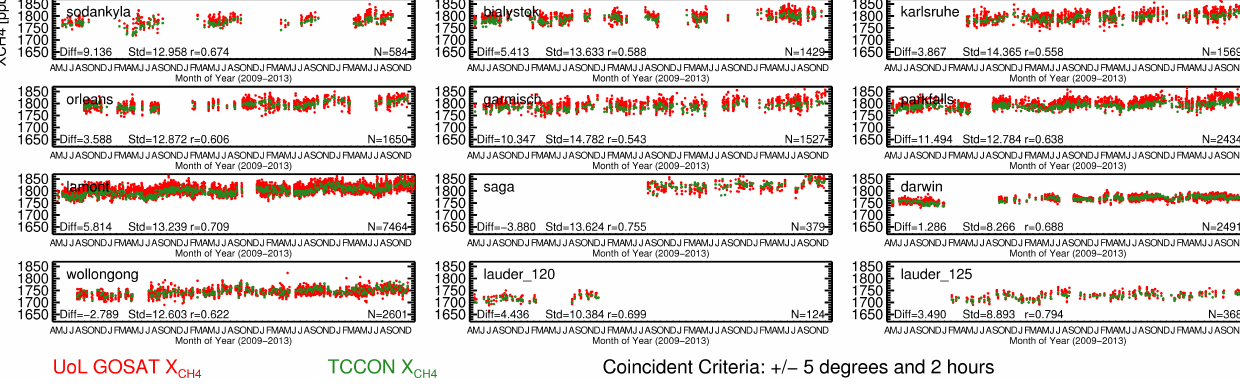
Figure 2. GGG2014 TCCON XCH 4 data and the Proxy XCH 4 plotted as time series for each TCCON site. The mean GOSAT − TCCON dif- ference, the standard deviation of the GOSAT − TCCON difference, the correlation coefficient, and the number of soundings are all provided for each